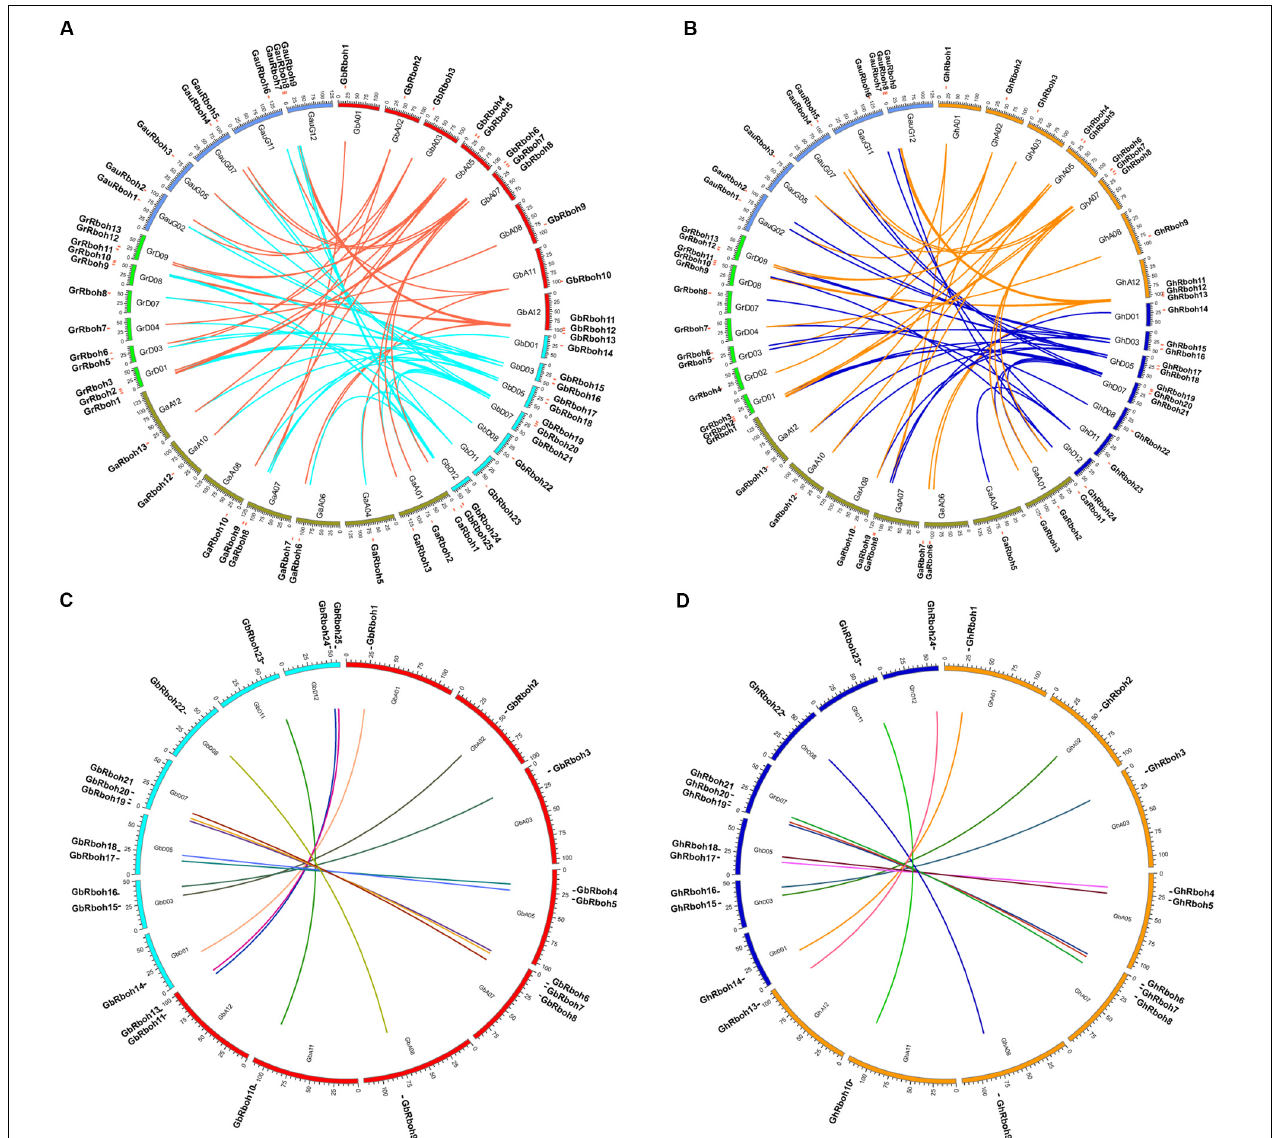
FIGURE 3 | Localization of cotton Rbohs on chromosomes. The genomic (At and Dt) analysis of Rboh genes in panels (A) G. barbadense and (B) G. hirsutum vis-à-vis the diploid Gossypium spp. Different-colored links indicate translocation from the A or D sub-genome of an allotetraploid cotton to the diploid cotton. Lined gene coupling represents a shared identity between them that exceeded 91%. The inter-genomic (At and Dt) analyses of Rboh genes in panels (C) G. barbadense and (D) G. hirsutum between the A and D sub-genomes. Different-colored lines indicate gene couples whose identity is over 98%, depicted using the Circos genome visualization tool